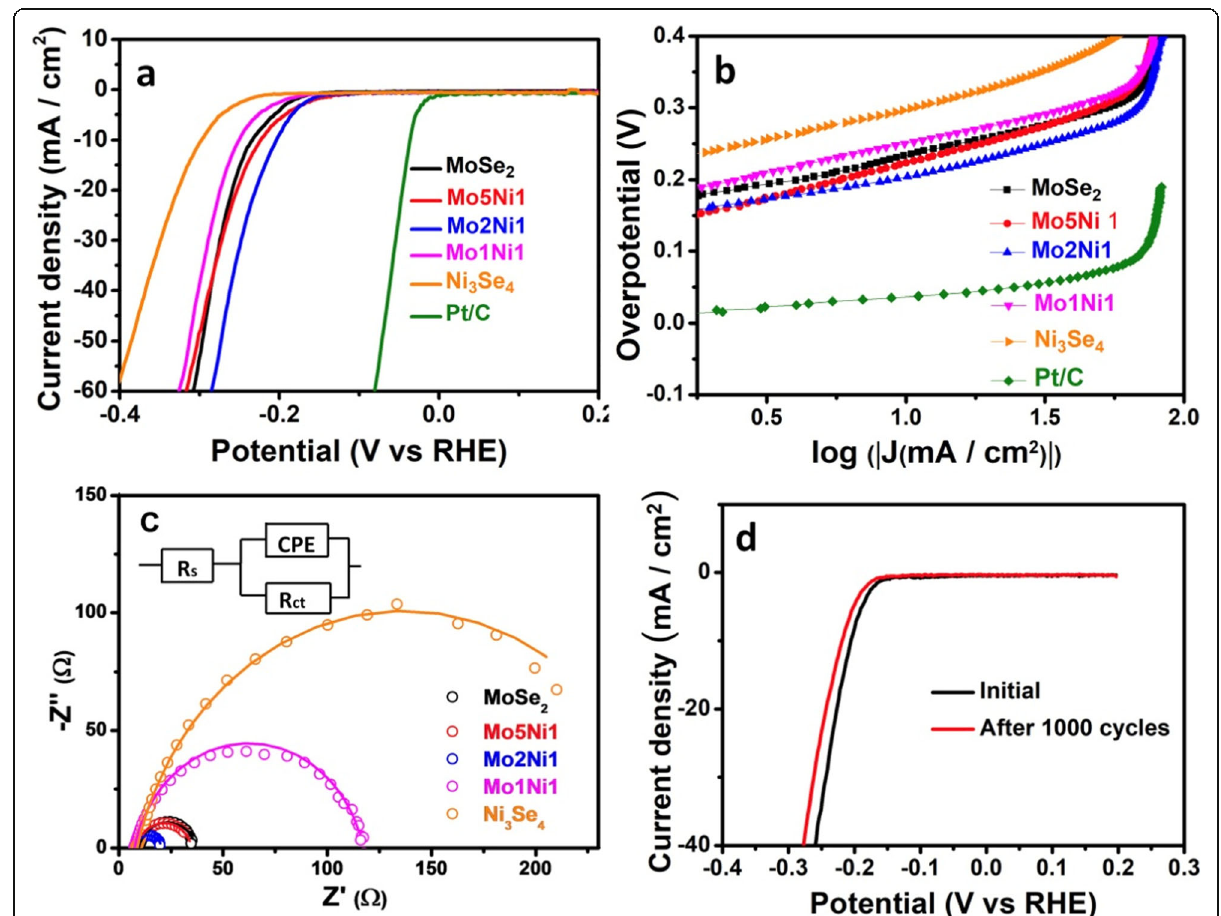
Fig. 6 Polarization curves ( a ) and corresponding Tafel plots ( b ) of MoSe 2 , Mo5Ni1, Mo2Ni1, Mo1Ni1, Ni 3 Se 4 , and Pt/C. c Nyquist plots at an overpotential of 250 mV. d Polarization curves of Mo2Ni1 sample before and after 1000